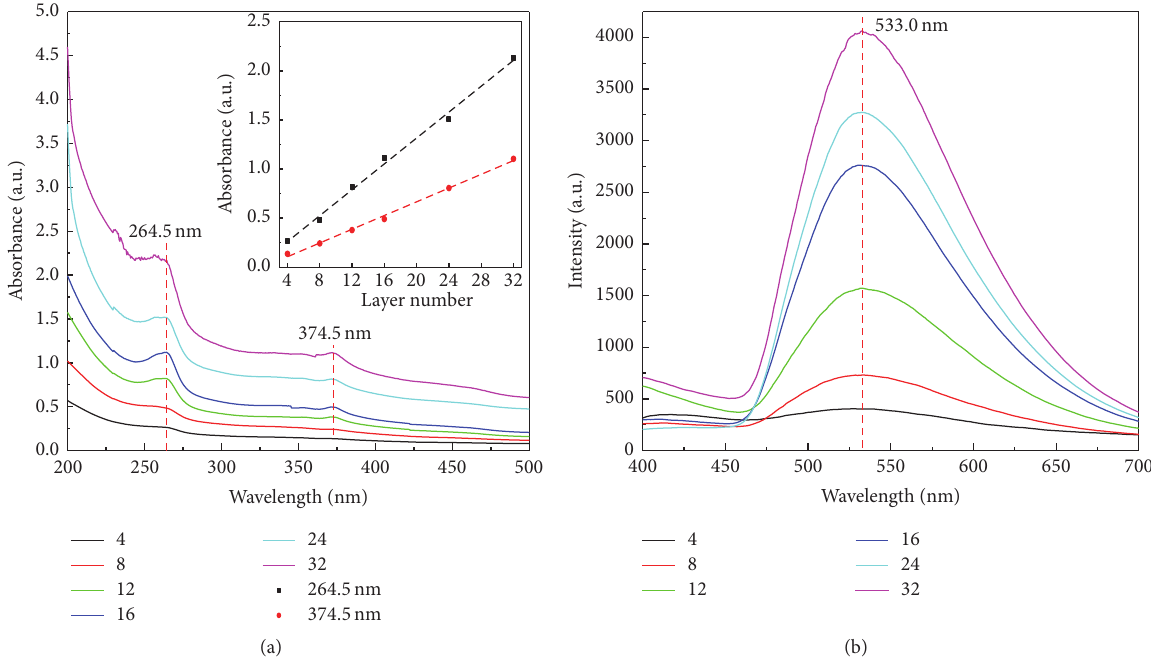
Figure 4: UV-visible absorption spectra and photoluminescence spectra of CoM( 𝑛 )-films. The inset of (a) shows the absorbance increasing linear relationship in 263.5 nm, 338.0 nm, and 375.0